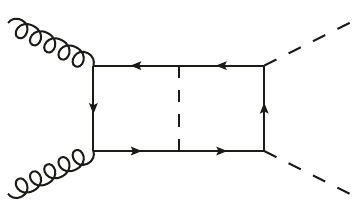
Figure 1 . Sample Feynman diagram with a Higgs boson exchange in the top quark loop. Straight, dashed and curly lines represent top quarks, Higgs bosons and gluons,